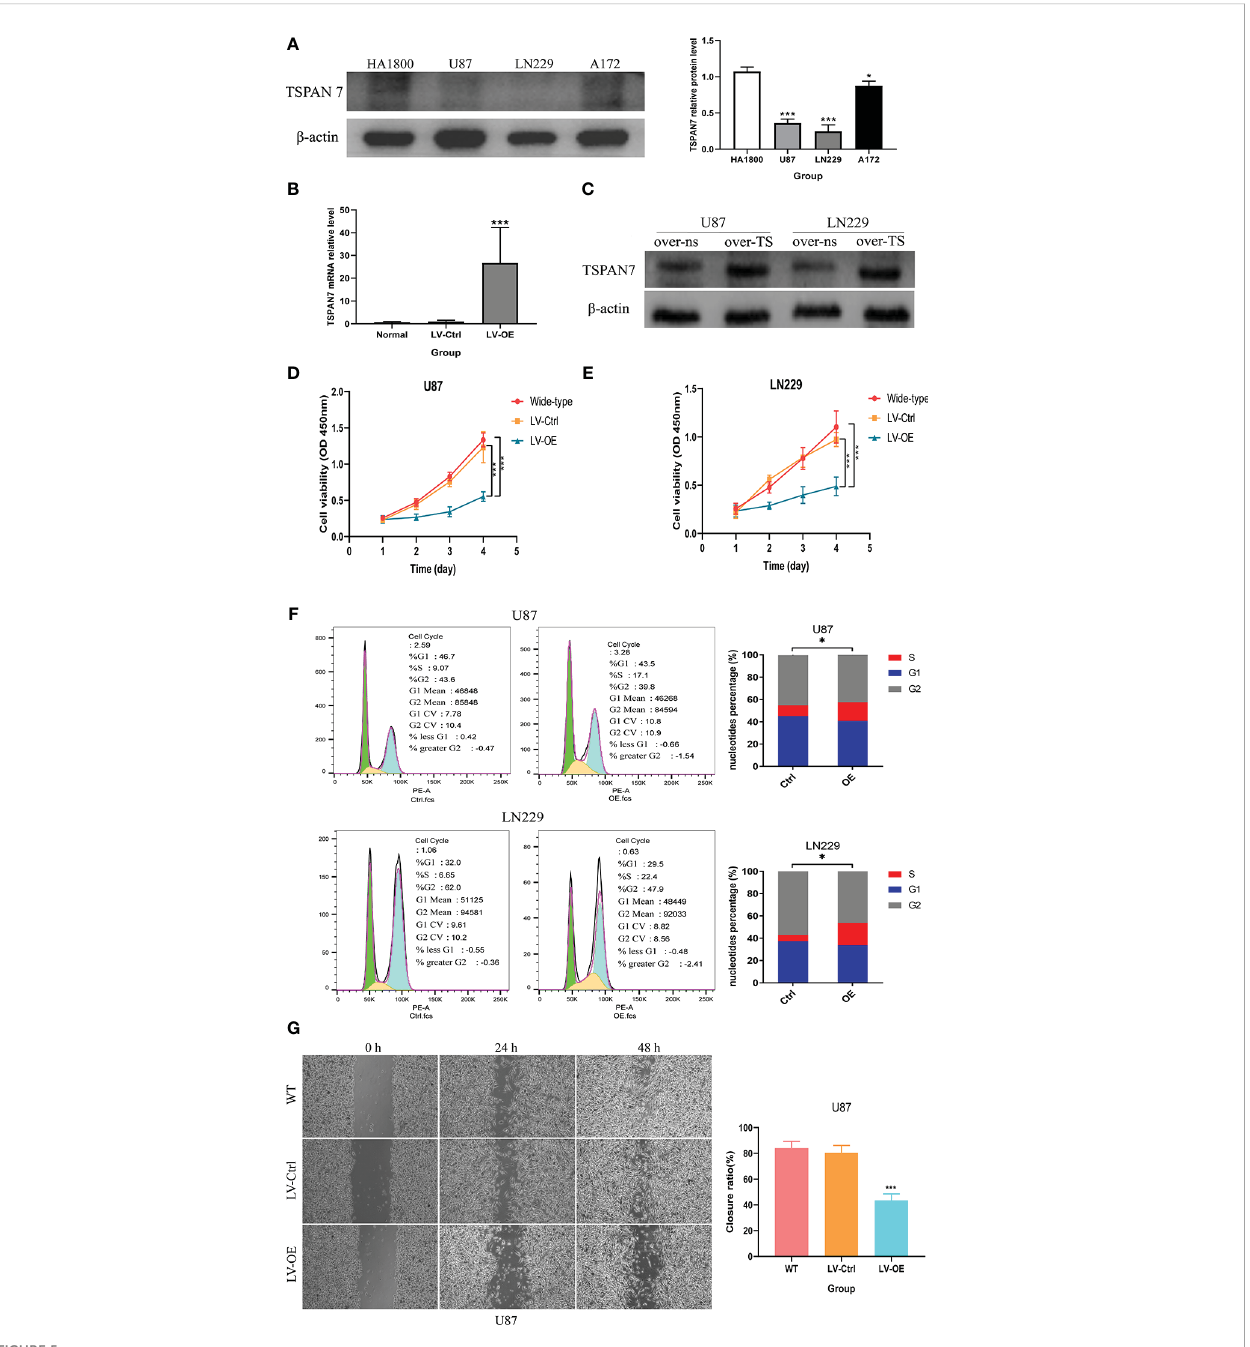
FIGURE 5 TSPAN7 expression in GBM is protective against cell proliferation, viability and migration in vitro. (A) The expression level of TSPAN7 in the three glioma cell lines and normal glia cells were detected by Western blot. (B, C) The mRNA expression levels of TSPAN7 in normal, control and TSPAN7- overexpressing cell plasmid transfection were detected by qPCR and Western blot. (D, E) CCK-8 assays showed the difference of proliferation capacity between wildtype, LV-Ctrl and TSPAN7-overexpression in U87 and LN229 cell lines. (F) Cell cycle differences between TSPAN7-overexpression and control subgroup by fl ow cytometry in U87 and LN229 cell lines. (G) Wound-healing assays showed that cell migration ability between wildtype, LV-Ctrl and TSPAN7 overexpression in U87 cell line, *p <.05, ***p <.001, ns: no